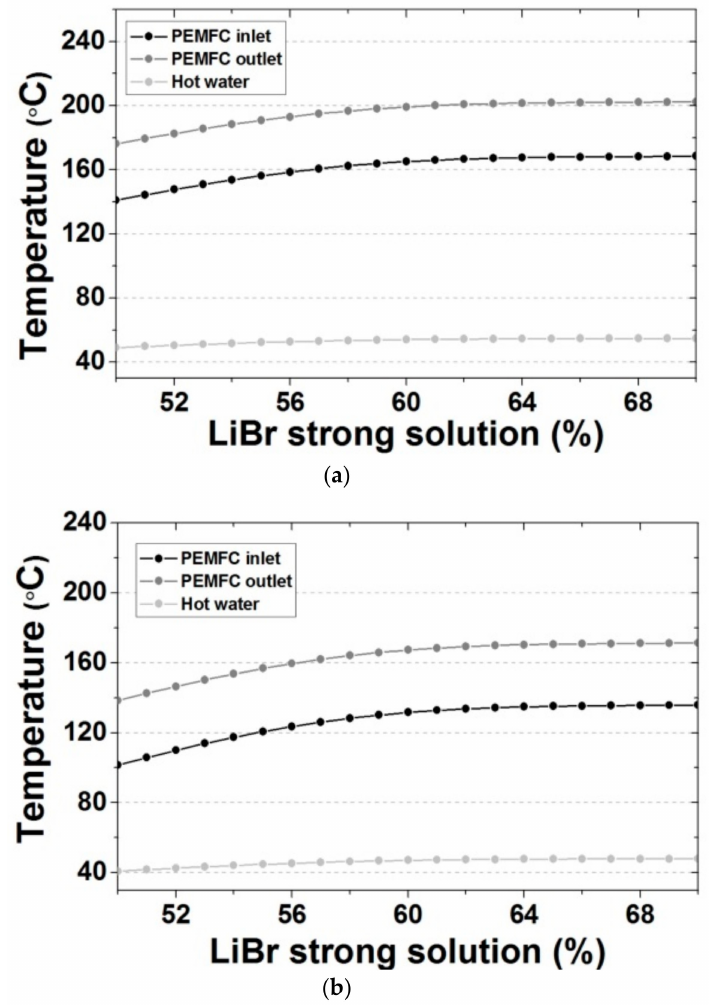
Figure 10. Comparison of stack in / out TEG and hot water temperature according to generator outlet LiBr aqueous solution concentration of absorption cooling system. ( a ) Absorption cooling capacity: 2.0 kW; ( b ) Absorption cooling capacity: 2.5